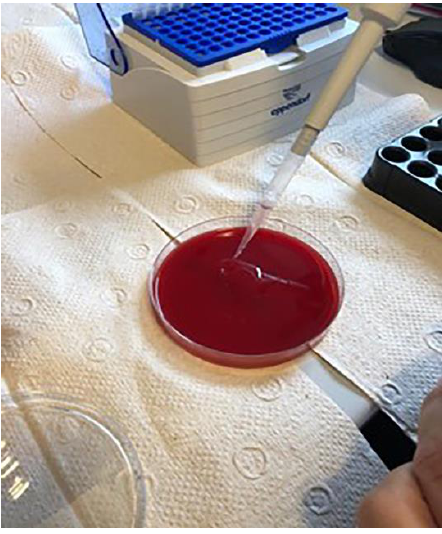
Figure 10. Application of samples on to blood agar.